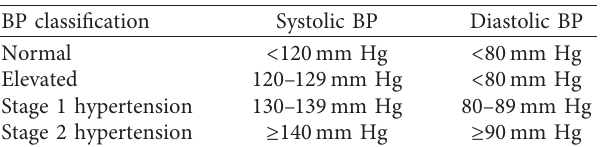
Table 1: Classification of blood pressure (BP) as per ACC/AHA 2017